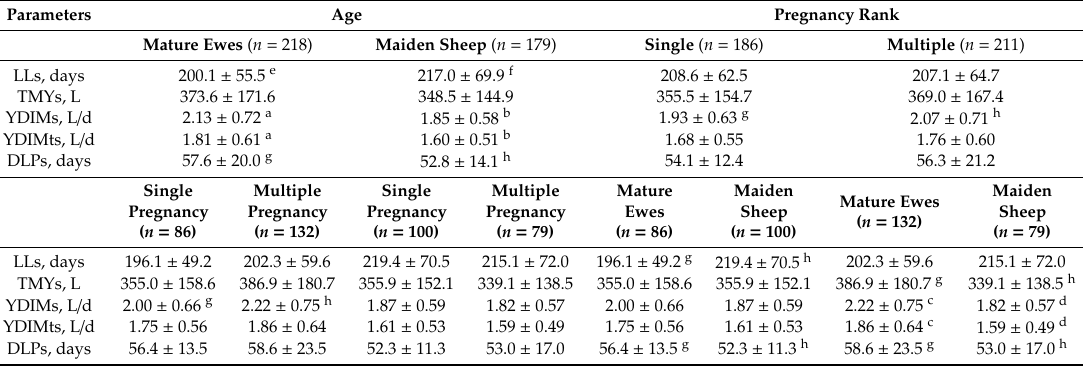
Table 4. Productivity parameters during the subsequent lactation in mature ewes and maiden sheep with single or multiple